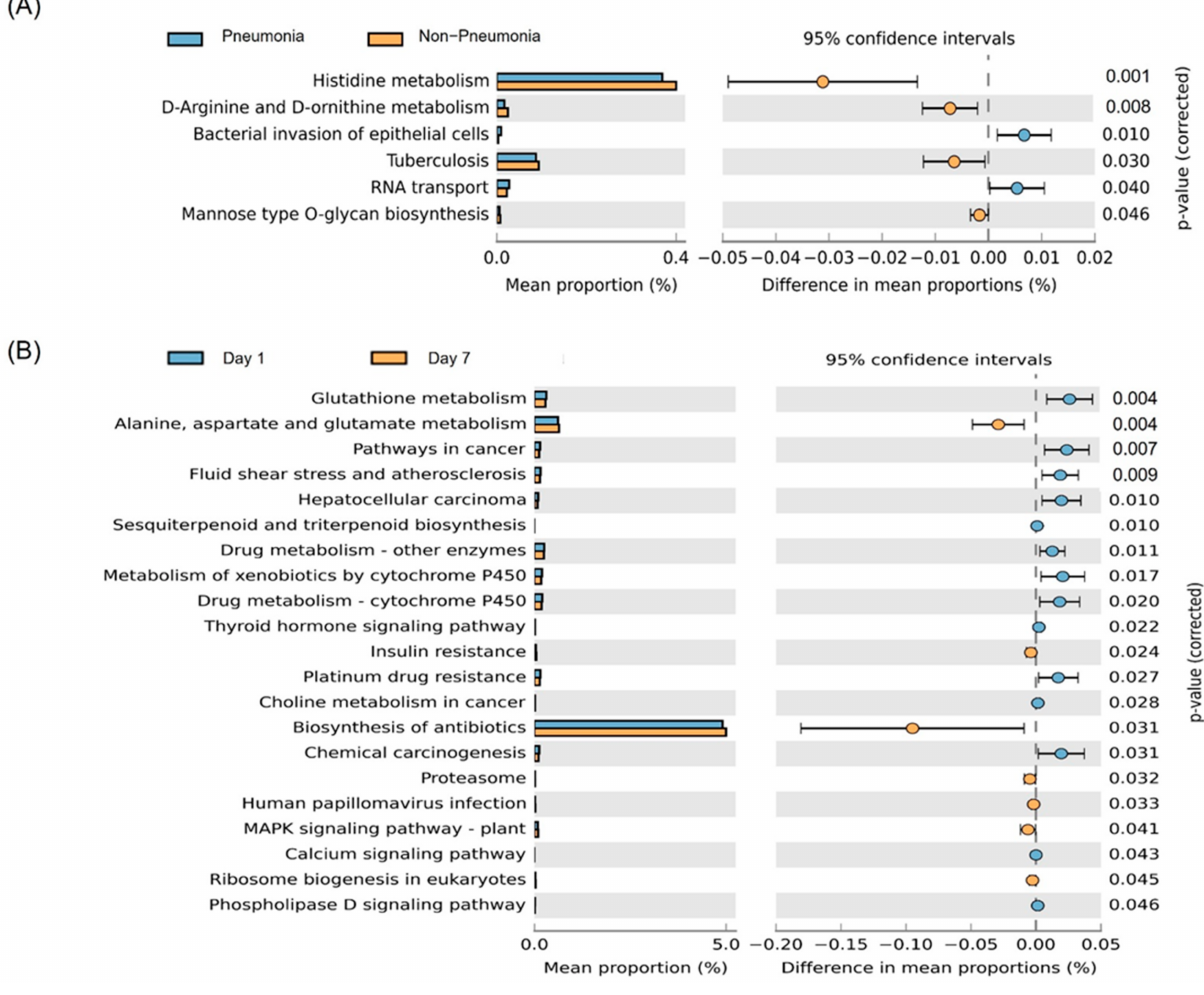
Figure 4. Predicted Kyoto Encyclopedia of Genes and Genomes pathways. ( A ) Level 3 functions showing differences between the pneumonia and non-pneumonia groups. ( B ) Level 3 functions showing differences over time in survivor